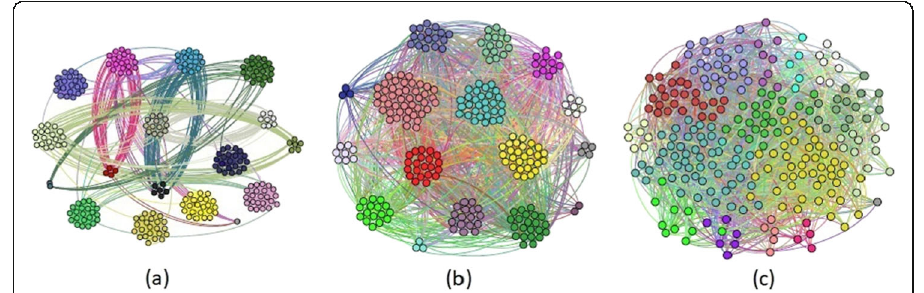
Fig. 1 Results of the clustering algorithm corresponding to LFR graphs with N = 250 and (a) μ = 0.1 , (b) μ = 0.3 and (c) μ =